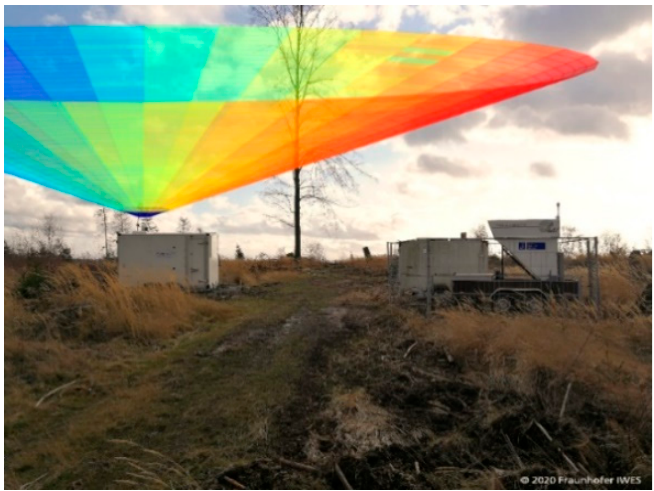
Figure 3. On-site installation of scanning lidar (left) and reference sodar (right) with illustration of scan pattern, color contours show example measurements of radial wind speed within scan. Cone angle and ranges seen here are an example used for illustration only. Table 2. Specifications of measurement campaign for scanning lidar and reference sodar measurements.